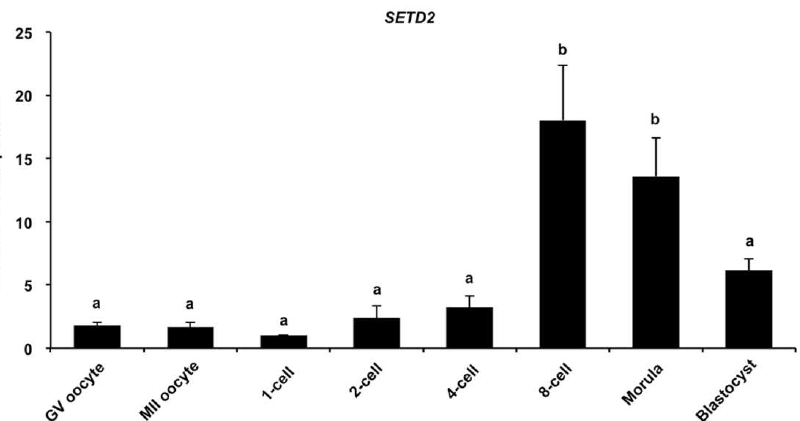
Figure 1. Expression of STED2 transcripts in oocytes and embryos. Relative expression of SETD2 transcripts was analyzed by qPCR. The independent experiment was carried out for three times and 40 embryos in each stage were at least included. GV, germinal vesicle; MII, metaphase II. Data are shown as mean ± S.E.M and different letters on the bars indicate significant differences ( p < 0.05).